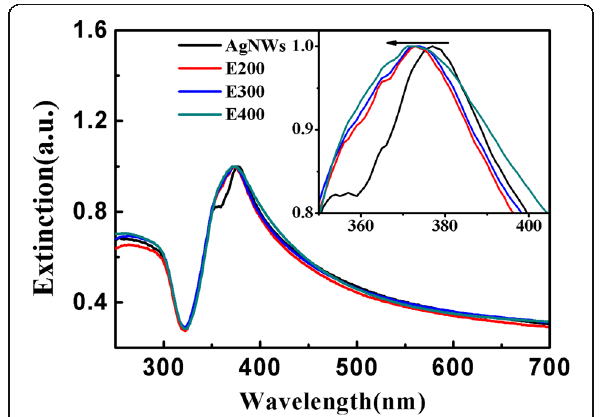
Fig. 3 AFM height images of as-synthesized Ag nanowires (denoted as AgNWs in figures) ( a ) and chemically etched Ag nanowires (denoted as E-AgNWs, the amount of etchant was 300 μ L) ( b ), AFM cross-sectional height profiles ( c ), and plot of average diameter versus height difference of as-synthesized and chemically etched Ag nanowires ( d )